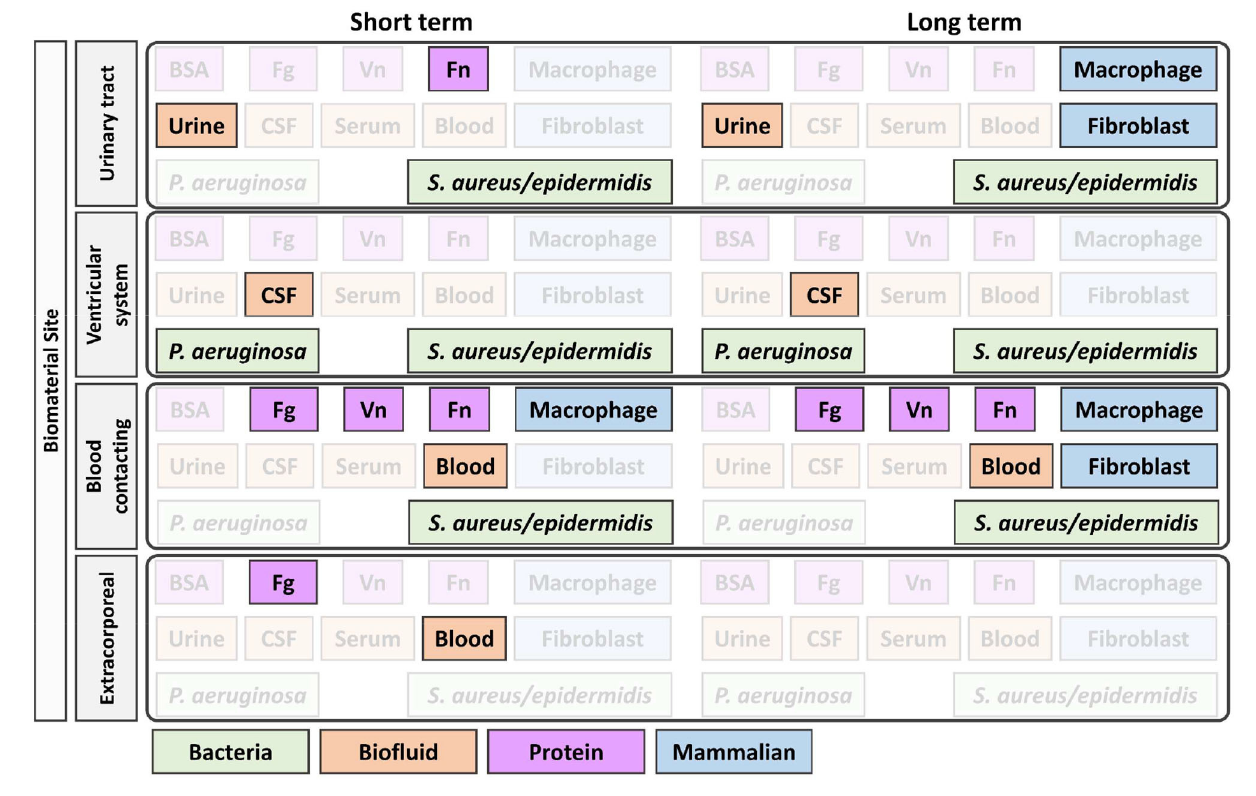
Frontiers in Chemistry |